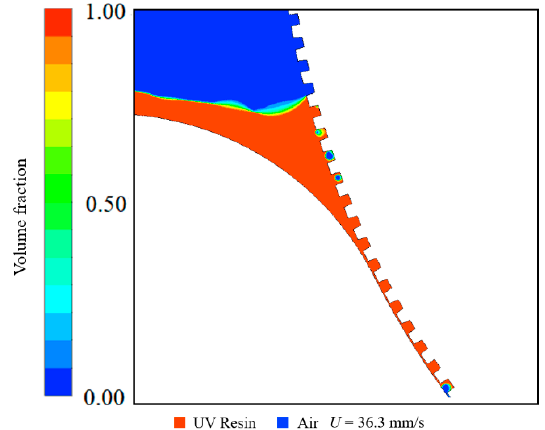
Figure 8. UV resin incomplete filling into the rectangular microcavities with a tapering angle of 5 ◦ at two ends of the roller mold at a PET web speed of 36.3 mm / s and t = 1 s ( θ R = 15 ◦ , θ P = 60 ◦ ).